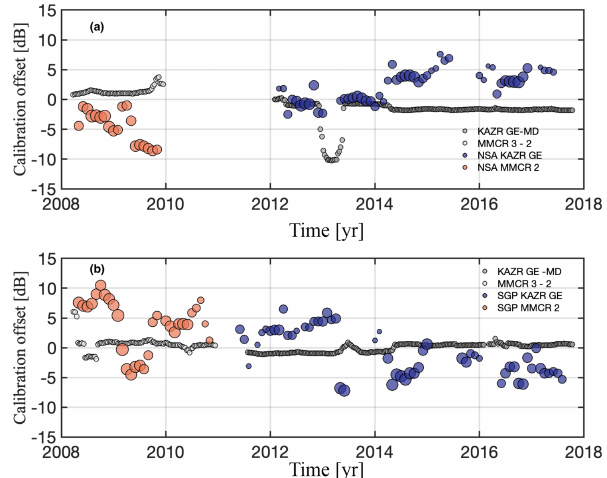
Figure 10. The calibration offset for the MMCR mode 2 and KAZR GE mode at (a) NSA and (b) SGP sites based on the ARM– CloudSat comparison. The size of the circles indicates the ratio of the sample size of the CloudSat columns for any given calibration offset estimate relative to the maximum sample size of CloudSat columns observed during the same period by the same mode. The gray circles indicate the ARM MMCR mode 3–mode 2 and KAZR GE–MD mode difference as estimated from the ARM radar mode intercomparison.